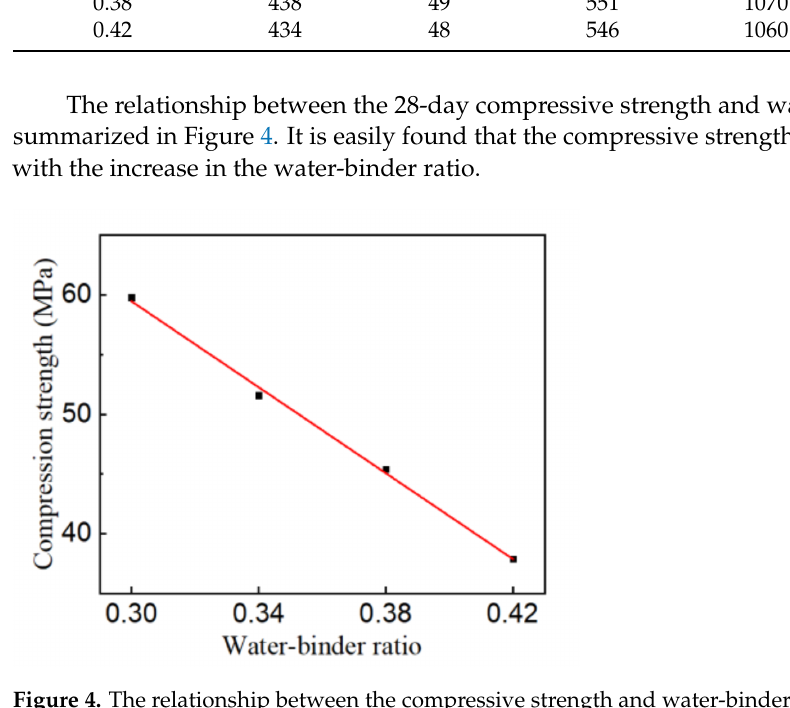
Figure 4. The relationship between the compressive strength and water-binder